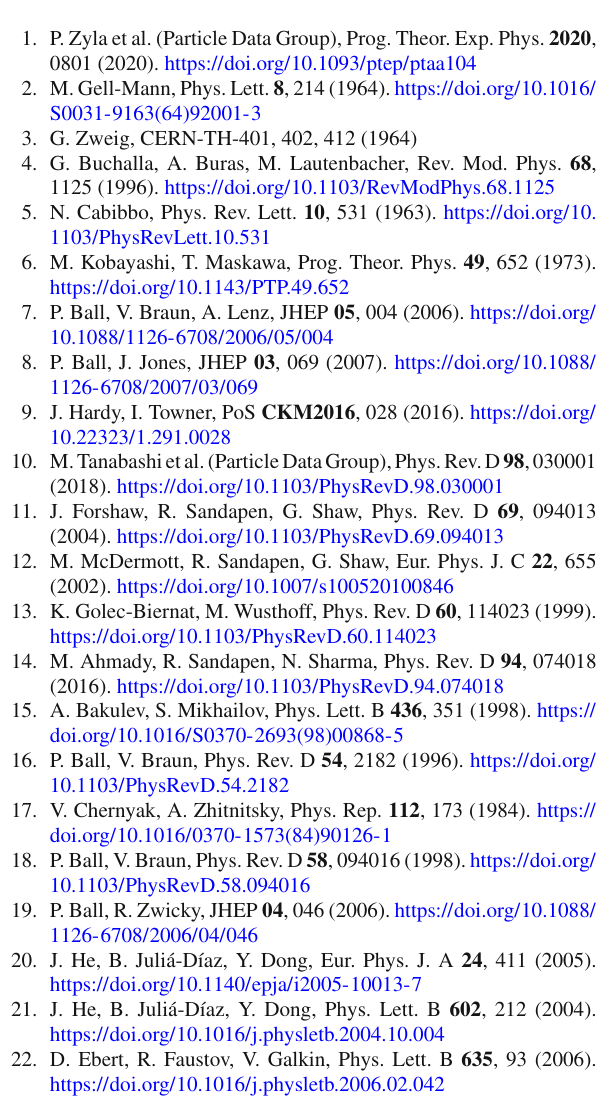
Table 7 The probabilities of experimental investigation on PLDCV, where B denotes the branching ratio, and the symbol (cid:21) denotes that the PLDCV process might be experimentally accessible in the future